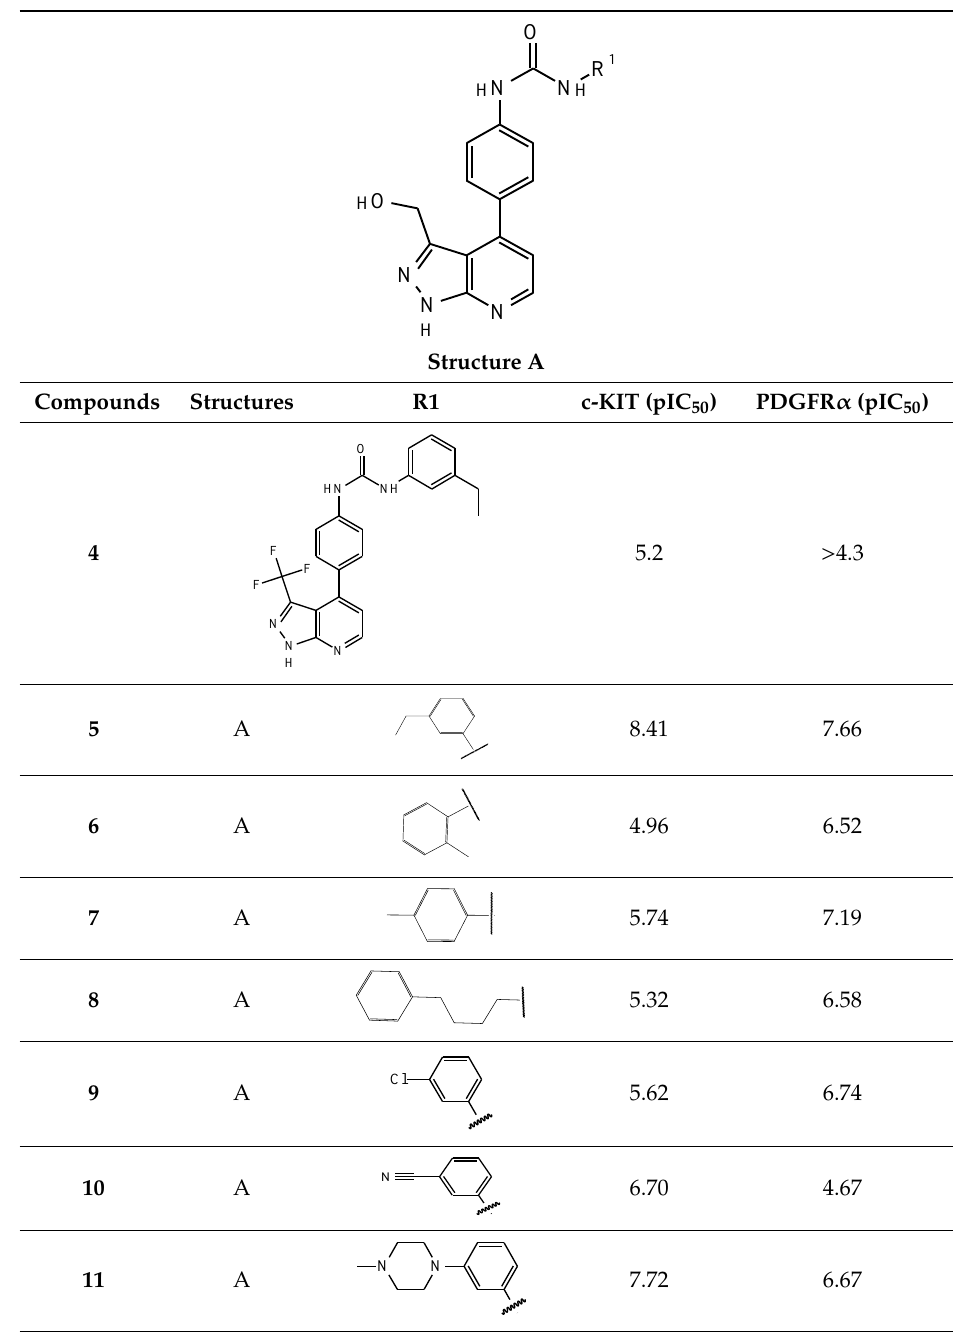
Table 1. Structure of the pyrazolopyridine derivatives and their pIC 50 values for stem cell factor receptor (c-KIT) and platelet-derived growth factor receptor alpha